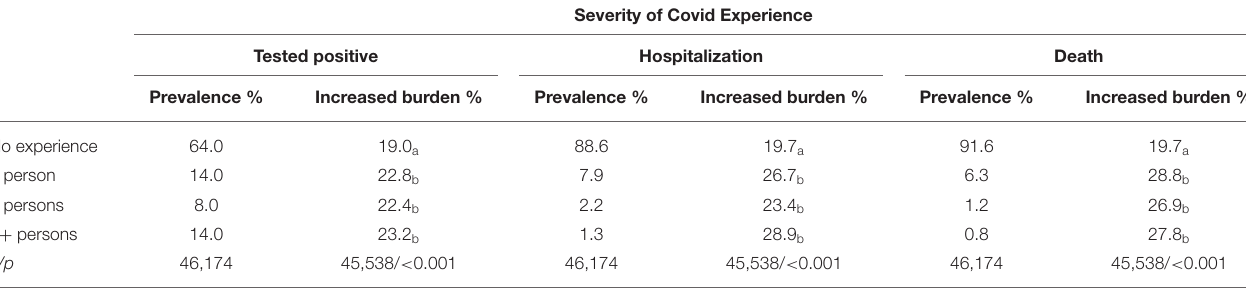
TABLE 2 | Descriptive and bivariate results of severity of COVID-19 experience and psychological burden increase.